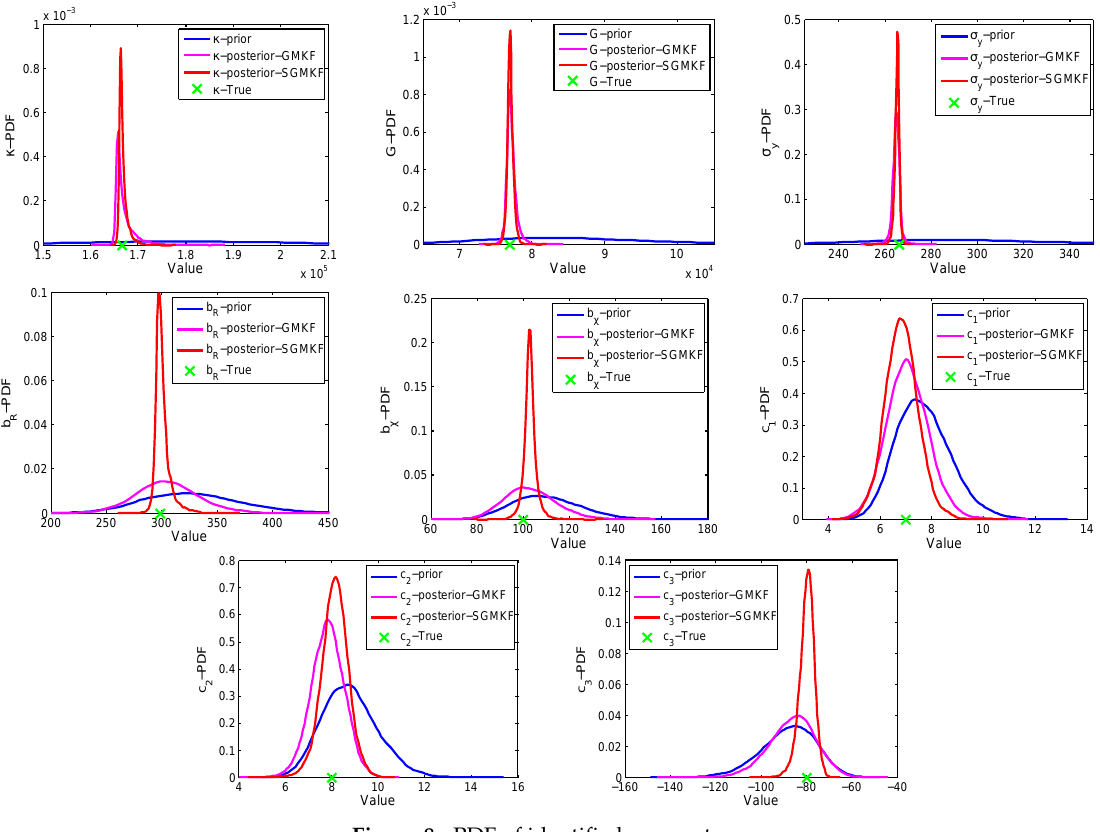
Figure 8. PDF of identified